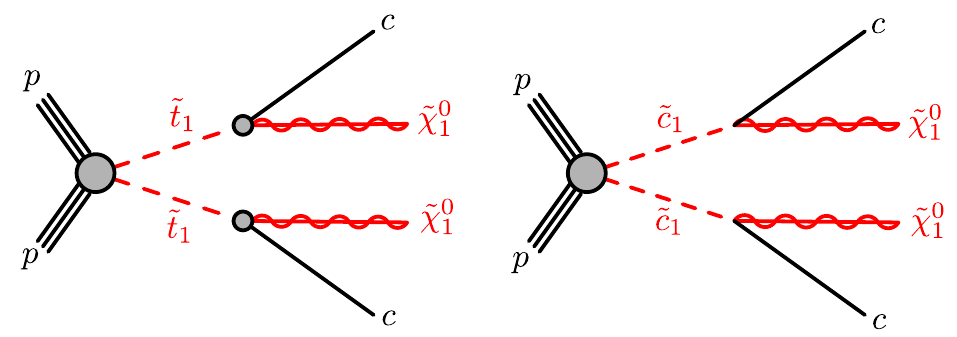
Figure 1 . Production diagrams for the pair production of top and charm squarks with subsequent decay into charm quarks and two LSPs. The di(cid:11)erentiation of particles and anti-particles is omitted in the diagrams but it is implicitly assumed. The direct squark production processes produce a top and charm squark-antisquark pair,